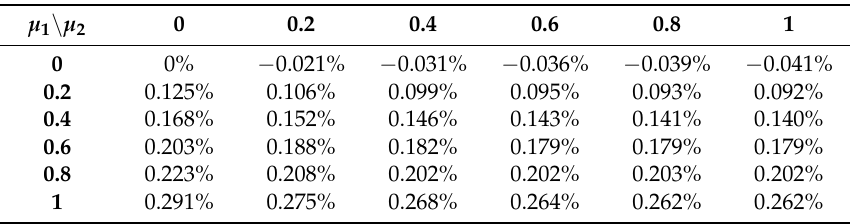
Table 5. Relative change of CVaR values for Genco1.